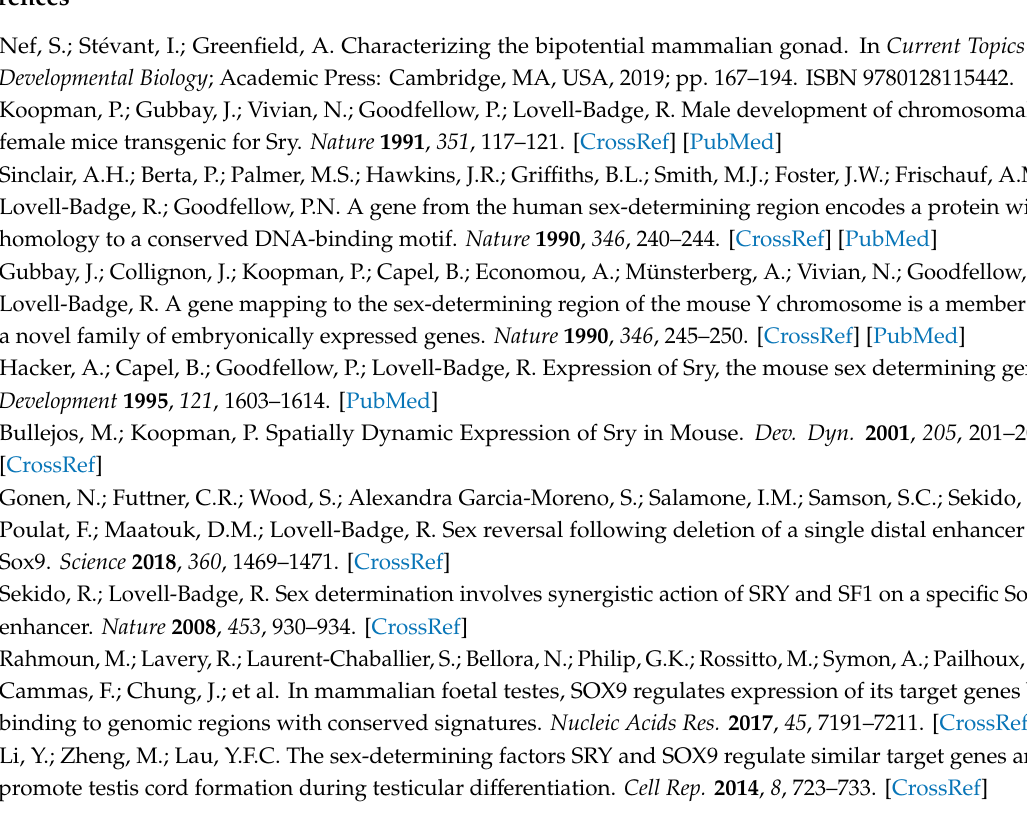
Figure S1: Sox9 expression in control and mutant gonads at E12.5 and E14.5; Figure S2: Phenotype of E14.5 XX control and mutant gonads; Figure S3: Quantitative PCR analysis of gene expression in XY control and mutant gonads at E14.5; Figure S4: Germ cell development in XY control and mutant gonads at E14.5; Table S1: Antibodies for immunodetection; Table S2: Quantitative-PCR